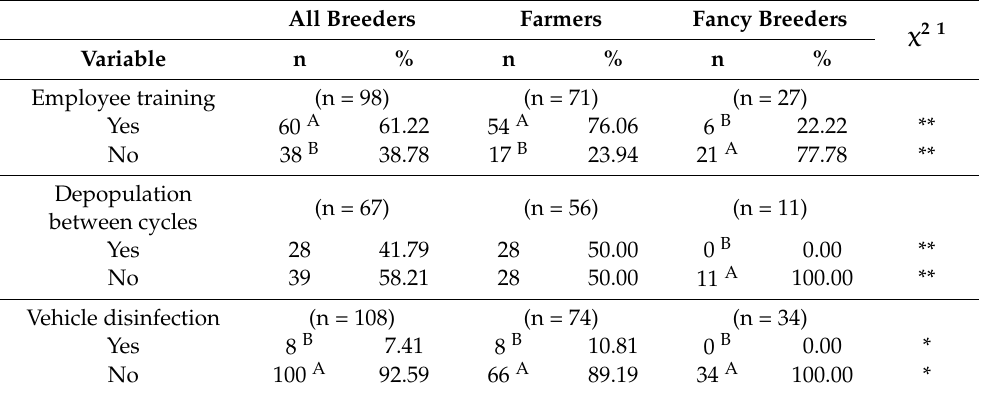
Table 12. Professional training and biosecurity practices employed: responses from all breeders and divided according to breeder category.